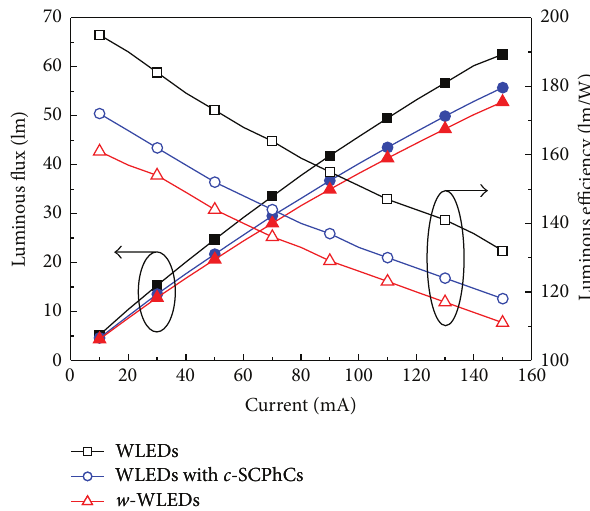
Figure 4: Current-dependent luminous flux (lm) and luminous efficiencies (lm/W) of the three types of WLEDs.